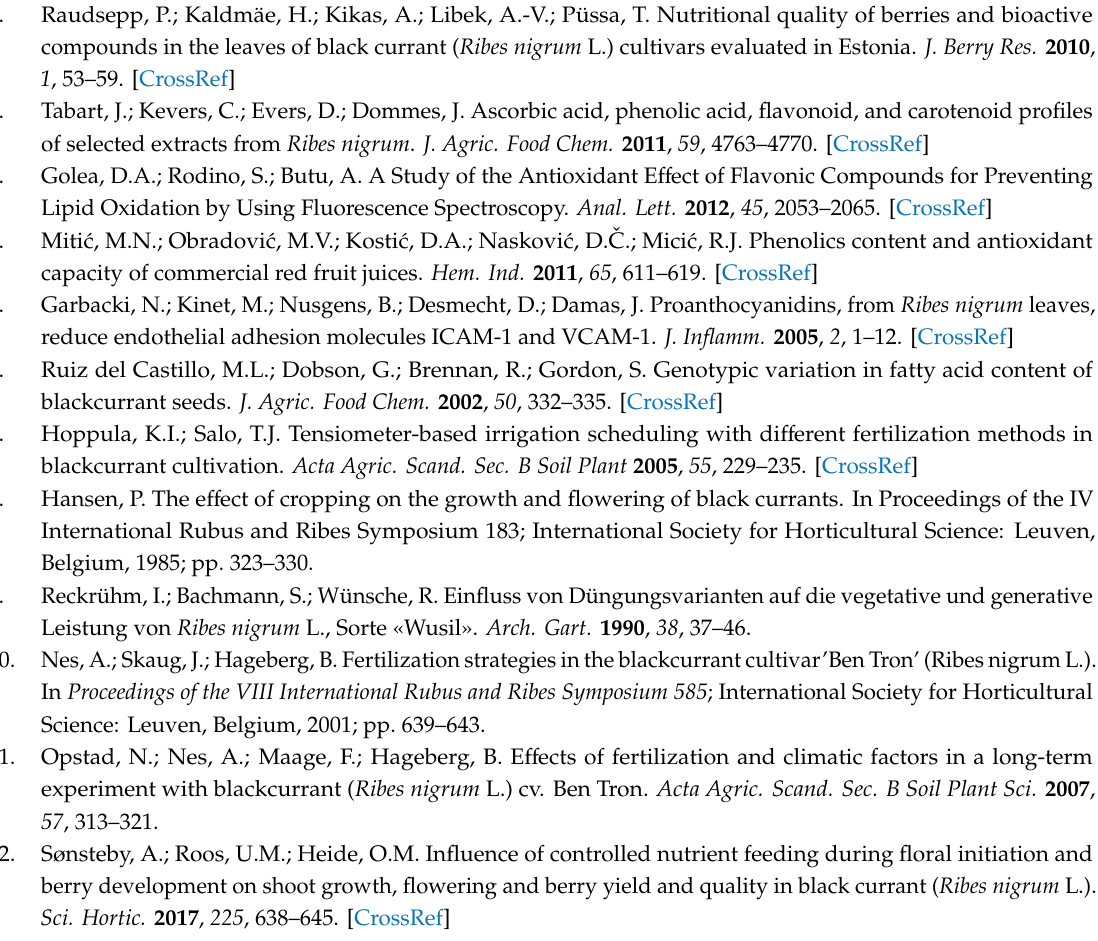
Table S1. PCA variance and variety-specific growth as a reaction fertilizer